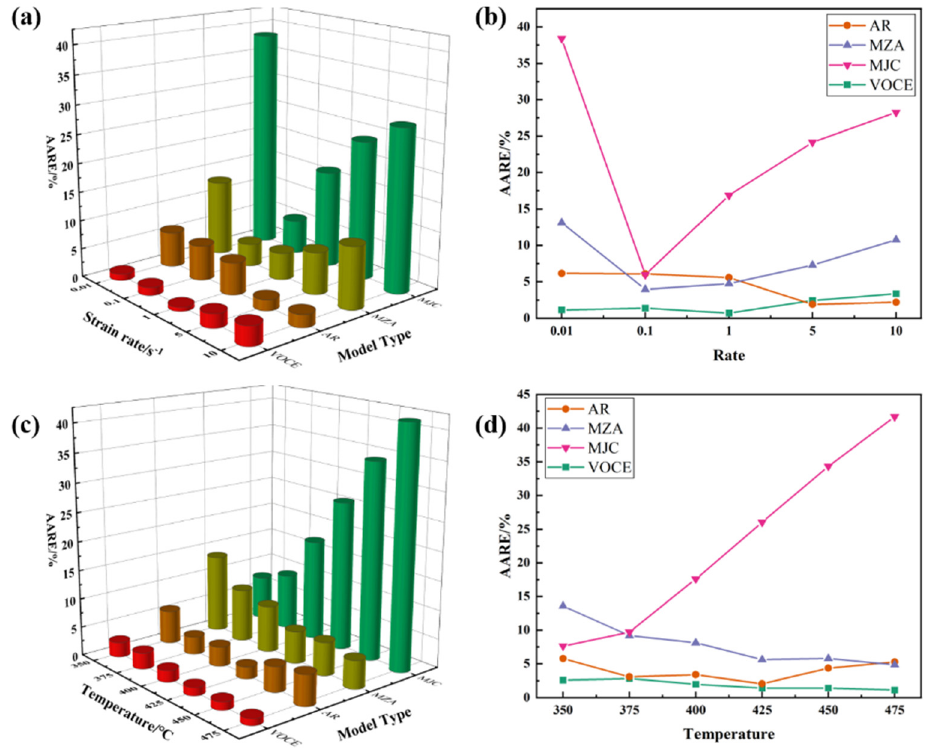
Figure 18. Schematic diagram of the effect of different deformation conditions on AARE. ( a , b ) Temperature; ( c , d ) Strain rate.